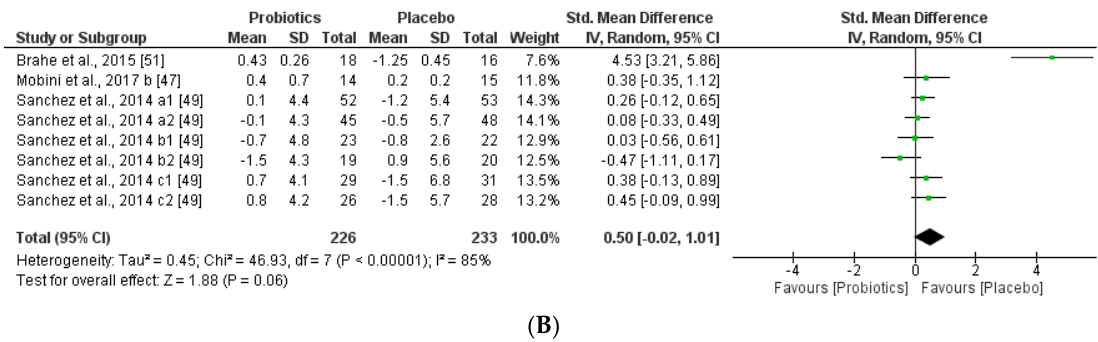
Figure 10. ( A ) Effect of probiotics on fasting plasma glucose in CT. ( B ) Effect of probiotics on CRP in Figure 10. ( A ) E ff ect of probiotics on fasting plasma glucose in CT. ( B ) E ff ect of probiotics on CRP in CT. CT.